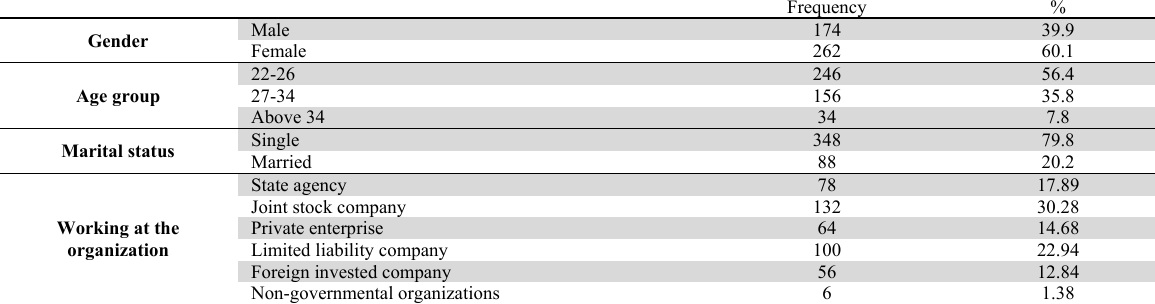
Summary of the results of sample